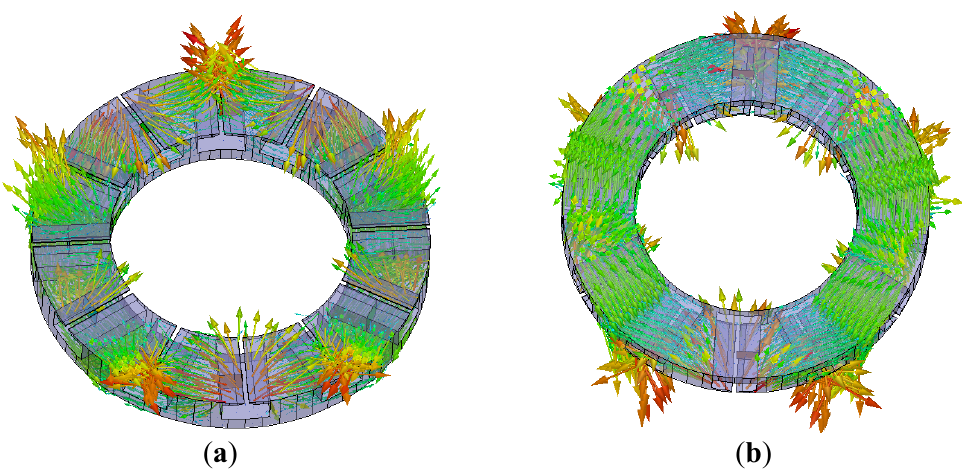
Figure 10. 3D distribution of magnetic flux density in the SMC stator when PMs sliding outward: ( a ) view from teeth side, and ( b ) view from yoke